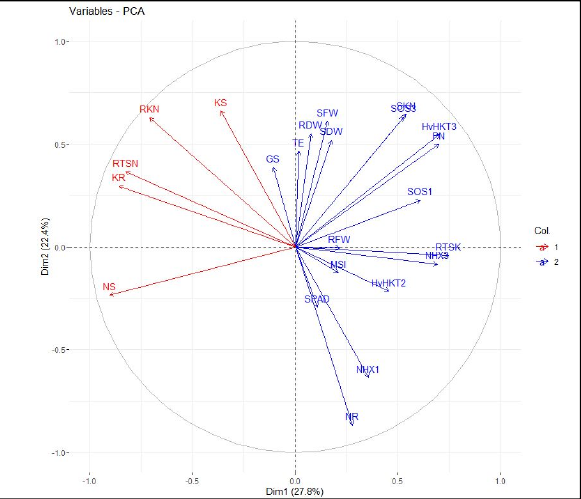
Figure 5. Principal component analysis (PCA) plot of measured traits and the relative gene expression data in the selected barley genotypes under salinity stress conditions. RFW, root fresh weight; SFW, shoot fresh weight; SDW, shoot dry weight; SPAD, relative chlorophyll content; P N , photosynthetic rate; G S , stomatal conductance; T E , transpiration rate; MSI, membrane stability index; RN, root Na + content; RK, root K + content; SN, shoot Na + content; SK, shoot K + content; RKN, root K + :Na + ratio; SKN, shoot K + :Na + ratio; RTSN, root-to-shoot Na + translocation; RTKN, root-to-shoot K + translocation; NHX1, expression of the HvNHX1 gene; NHX3, expression of the HvNHX3 gene; SOS1, expression of the HvSOS1 gene; SOS3, expression of the HvSOS3 gene; HvHKT2 , expression of the HvHKT2 gene; HvHKT3 , expression of the HvHKT3